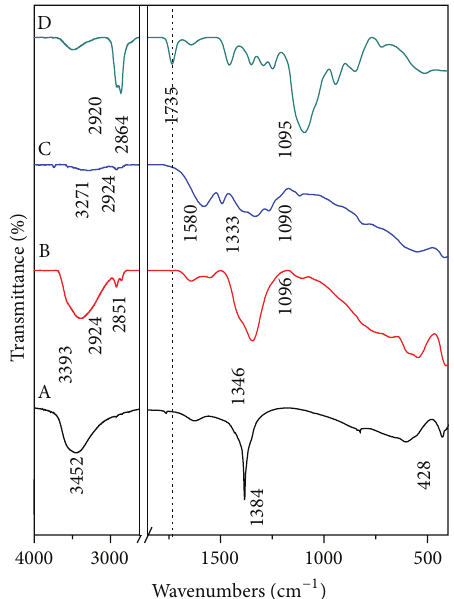
Figure 4: Fourier transform infrared spectra of Zn/Al-LDH (A), Tween-LDH (B), Tween-dopa-LDH nanocomposite (C), and free Tween-80